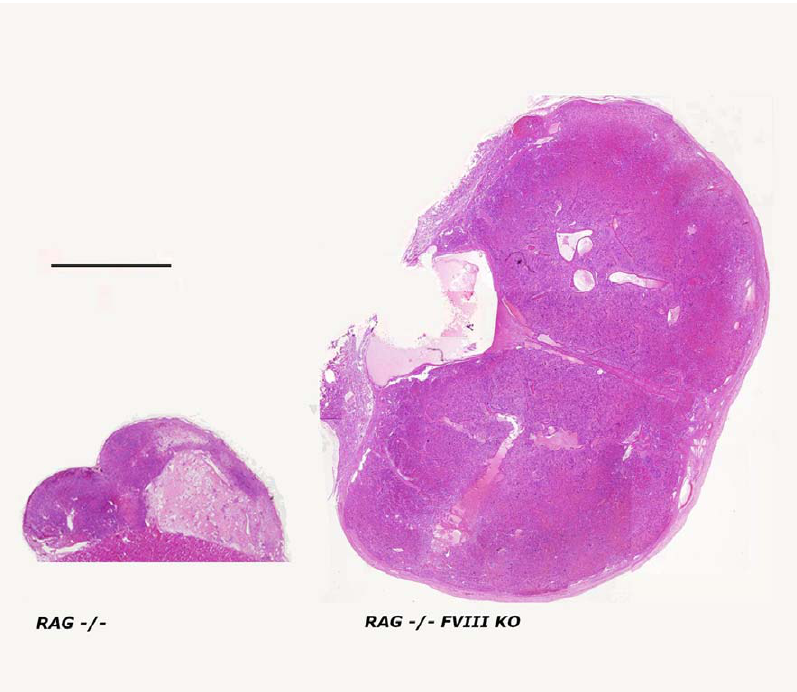
Figure 4. H&E staining of an E42 pig spleen implant 12 weeks following transplantation. Oversized spleen implant is shown in RAG 2 / 2 FVIII KO compared to its non-hemophilic RAG 2 / 2 counterpart. Bar indicates 2 endothelial cells, vascular smooth muscle cells (VSMC), mono-